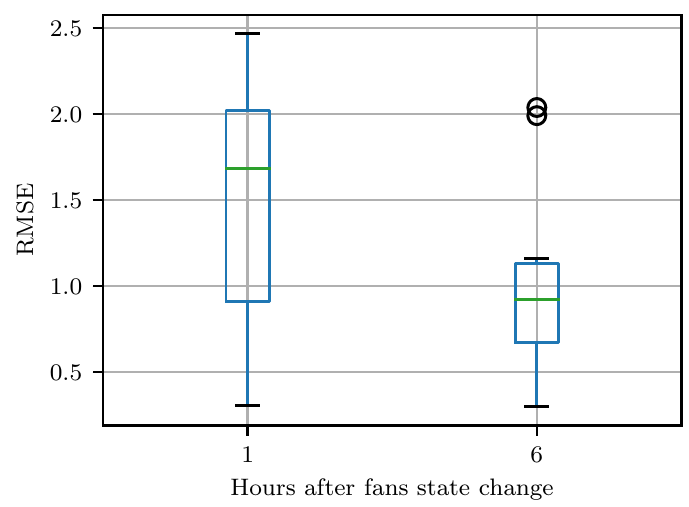
Figure 9. Box-plot of the temperature responses of all fan state changes.